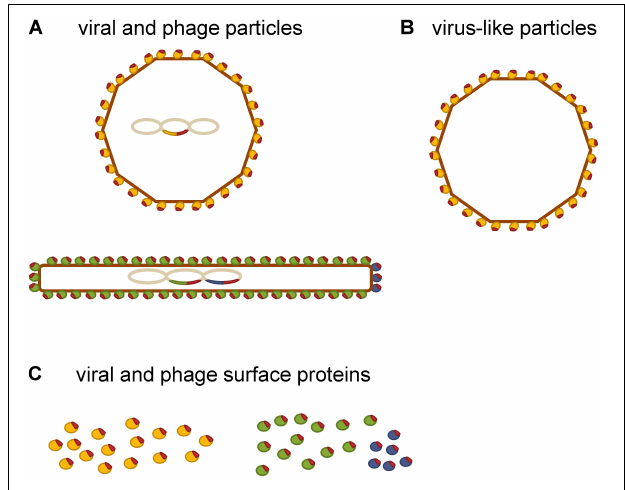
FIGURE 1 | Schematic representation of viral delivery vehicles that have been tested for use in allergy immunotherapy. (A) Viral and phage delivery vehicles displaying allergen-derived peptides (red) on their surface. (B) Virus-like particles as delivery vehicles of allergens or allergen-derived peptides (red) that are incorporated into the virus-like particle either by chemical coupling or by recombinant expression as fusion proteins. (C) Single viral (yellow) and phage surface protein carriers (green and blue) of allergen-derived